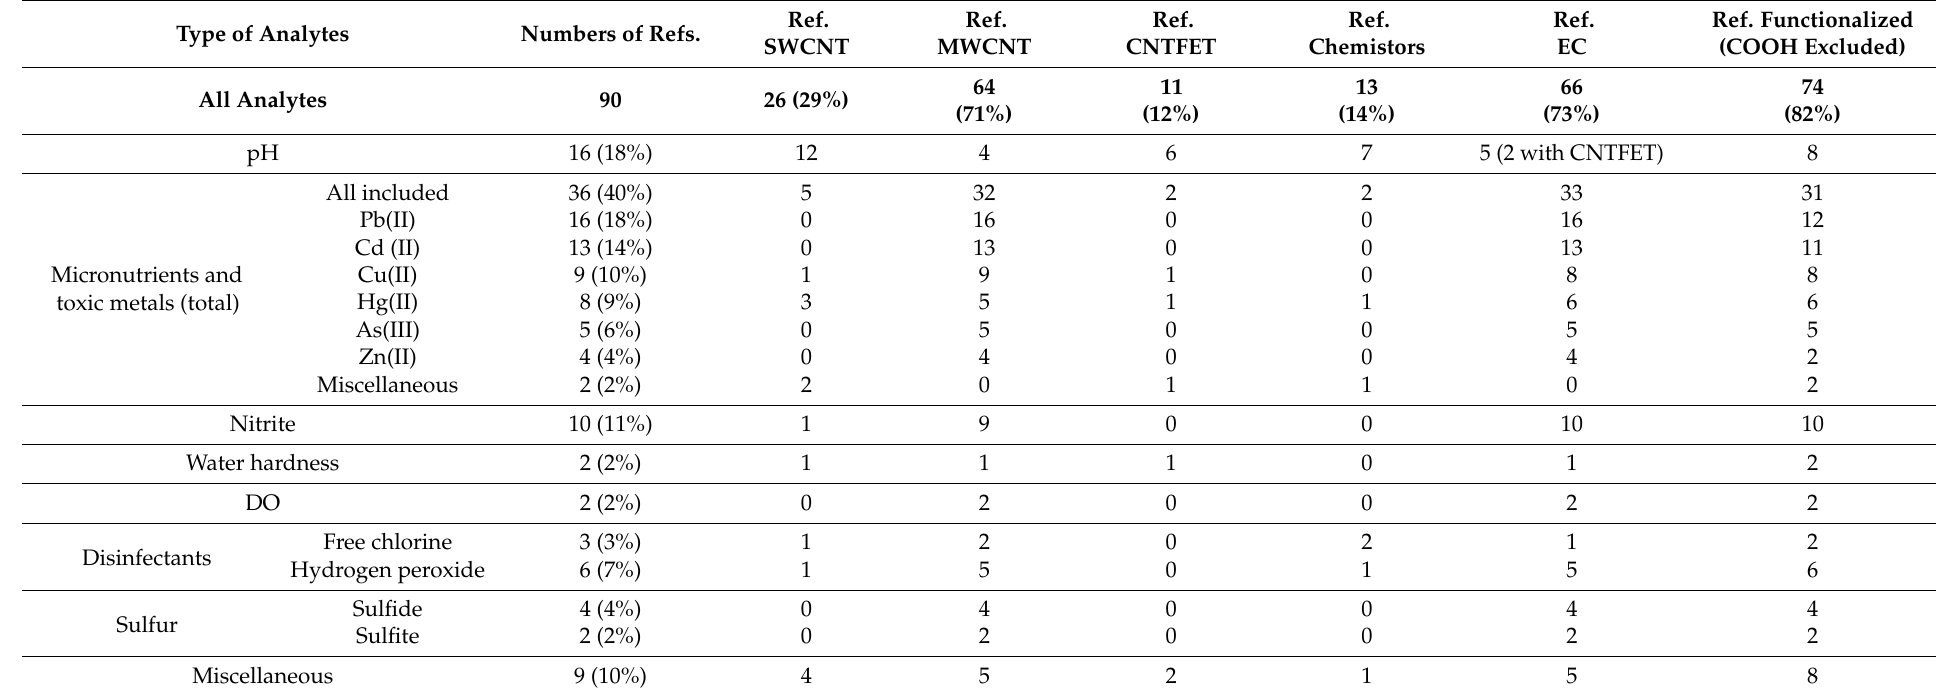
Table 1. Overview of reported CNT-based water quality monitoring